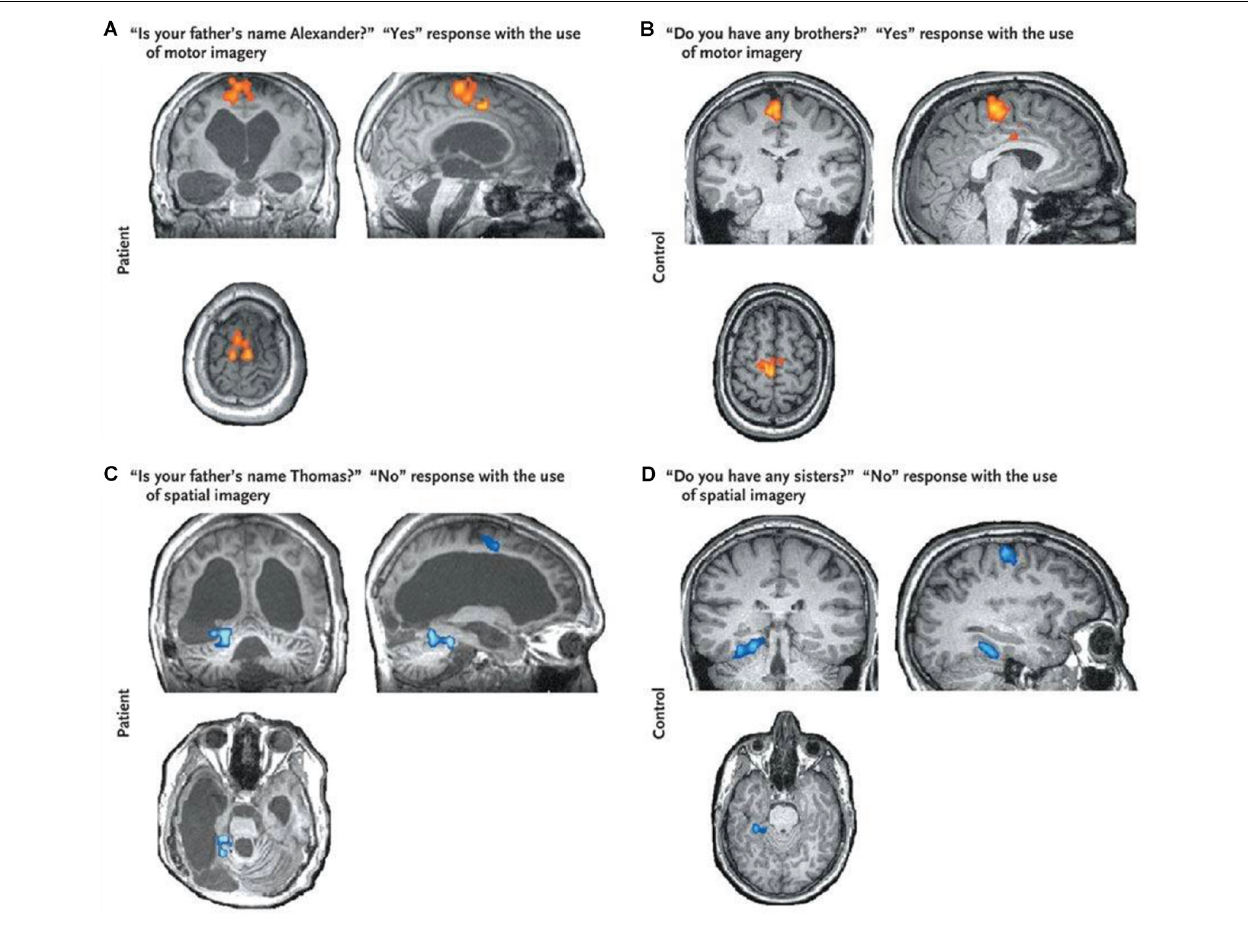
FIGURE 2 | Brain responses to questions obtained from a VS patient (panels A–C ) and that obtained from a healthy control (panel D ). The “Yes” response shows clear activation in the supplementary motor area (SMA; shown in red) suggesting the patient was imagining playing tennis and therefore trying to answer “Yes” to the question. The “No” response shows activation in the parahippocampal gyrus (shown in blue) suggesting the patient was imagining moving around his home and therefore trying to answer “No” to the question. Brain activity from both responses was indistinguishable from that of a healthy control. This figure was retrieved from Monti et al.